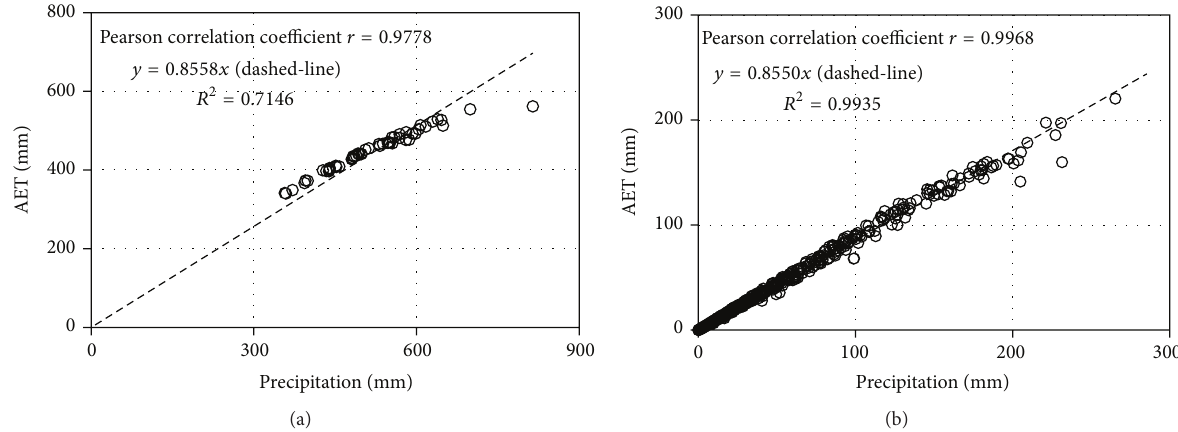
Figure 12: Annual and monthly relations between actual evapotranspiration and precipitation: (a) annual relation; (b) monthly relation.